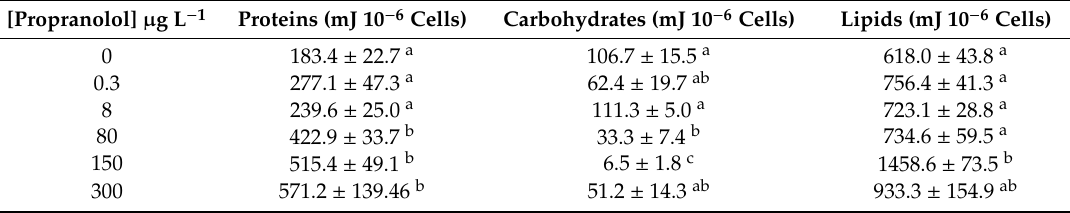
Figure 6. Mitochondrial electron transport system (ETS, A ), available energy (Ea, B ) and cellular energy allocation (CEA, C ) in Phaeodactylum tricornutum cultures exposed to di ff erent propranolol concentrations (average ± standard error, n = 3, letters denote di ff erences at p < 0.05). Table 2. Total proteins, carbohydrates and lipids Phaeodactylum tricornutum cultures exposed to di ff erent propranolol concentrations (average ± standard error, n = 3, letters denote di ff erences at p <